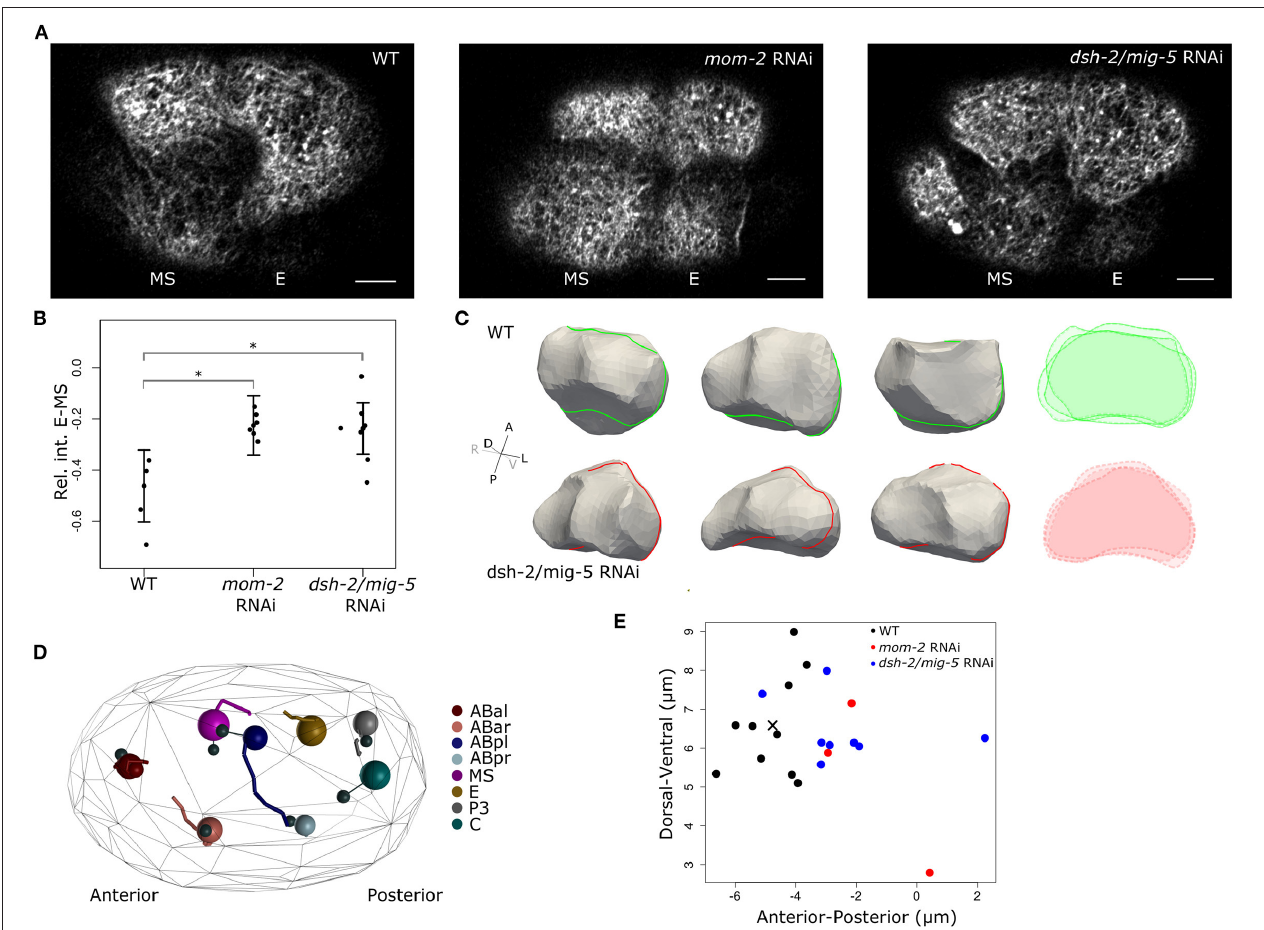
FIGURE 3 | Wnt signaling drives asymmetric cortical behavior during and after EMS division. (A) Cortical images showing effect on F-actin distribution when Wnt signaling is disrupted. F-actin shows nearly symmetric distribution between the E and MS daughters when either the Wnt ligand ( mom-2 ) or the disheveled proteins ( dsh-2, mig-5 ) are knocked down. Images are taken 3–5 min after completion of cytokinesis. Scale bars indicate 5 µ m. (B) Quantification of the effect of disruption of Wnt signaling on F-actin asymmetry between E and MS. Cortical intensity is measured and corrected as before, the shown values are the difference in intensity between E and MS (E-MS). Error bars represent the standard error and are centered around the mean. (C) Shape reconstruction of the E cell in both wildtype and dsh-2/mig-5 RNAi embryos 3’ after EMS division, with overlaid intersections shown in the right panel. At the shown moment, the perturbed embryos have more irregularly shaped E cells, with in some embryos a marked indentation at the posterior side by P2 as it is going through division. (D) Disrupting Wnt signaling induces a minor positional phenotype at the eight-cell stage. Systematic analysis of cellular positioning by lineaging 8 embryos treated with dsh-2/mig-5 RNAi showed a slightly more posterior positioning of the ABpl cell. The large spheres represent the cells in a perturbed embryo. The positioning in the reference embryos is shown by connecting the cells to small black spheres that represent the cells’ average position in reference embryos. The movements of the cells are shown by traces in the same color. (E) Position of ABpl in wild type and RNAi embryos. ABpl is consistently positioned more to the posterior when the Wnt signal is disrupted by RNAi for either the Wnt ligand ( mom-2 ) or the Dsh proteins ( dsh-2/mig-5 ) (cross indicates the average WT position). The cross marks the average position of ABpl in the reference embryos. *indicates significance at the 0.05